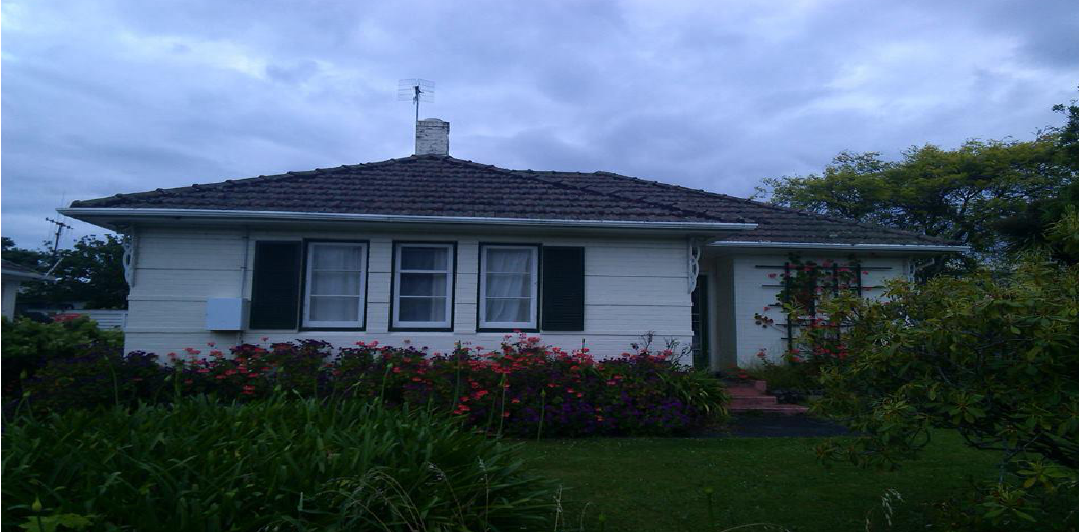
Figure 2. A more than seven-decade-old house where the Smart Aging system was installed without any significant changes in the house.